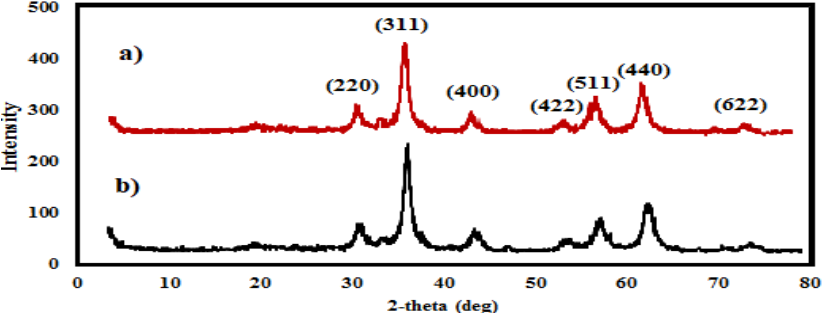
Figure 2. Powdered XRD diffraction patterns of magnetite nanomaterials coated by a ) M. aurea extract (MAE-MNMs) and b ) O. baccatus extract (OBE-MNMs). The peaks indices are indicated.